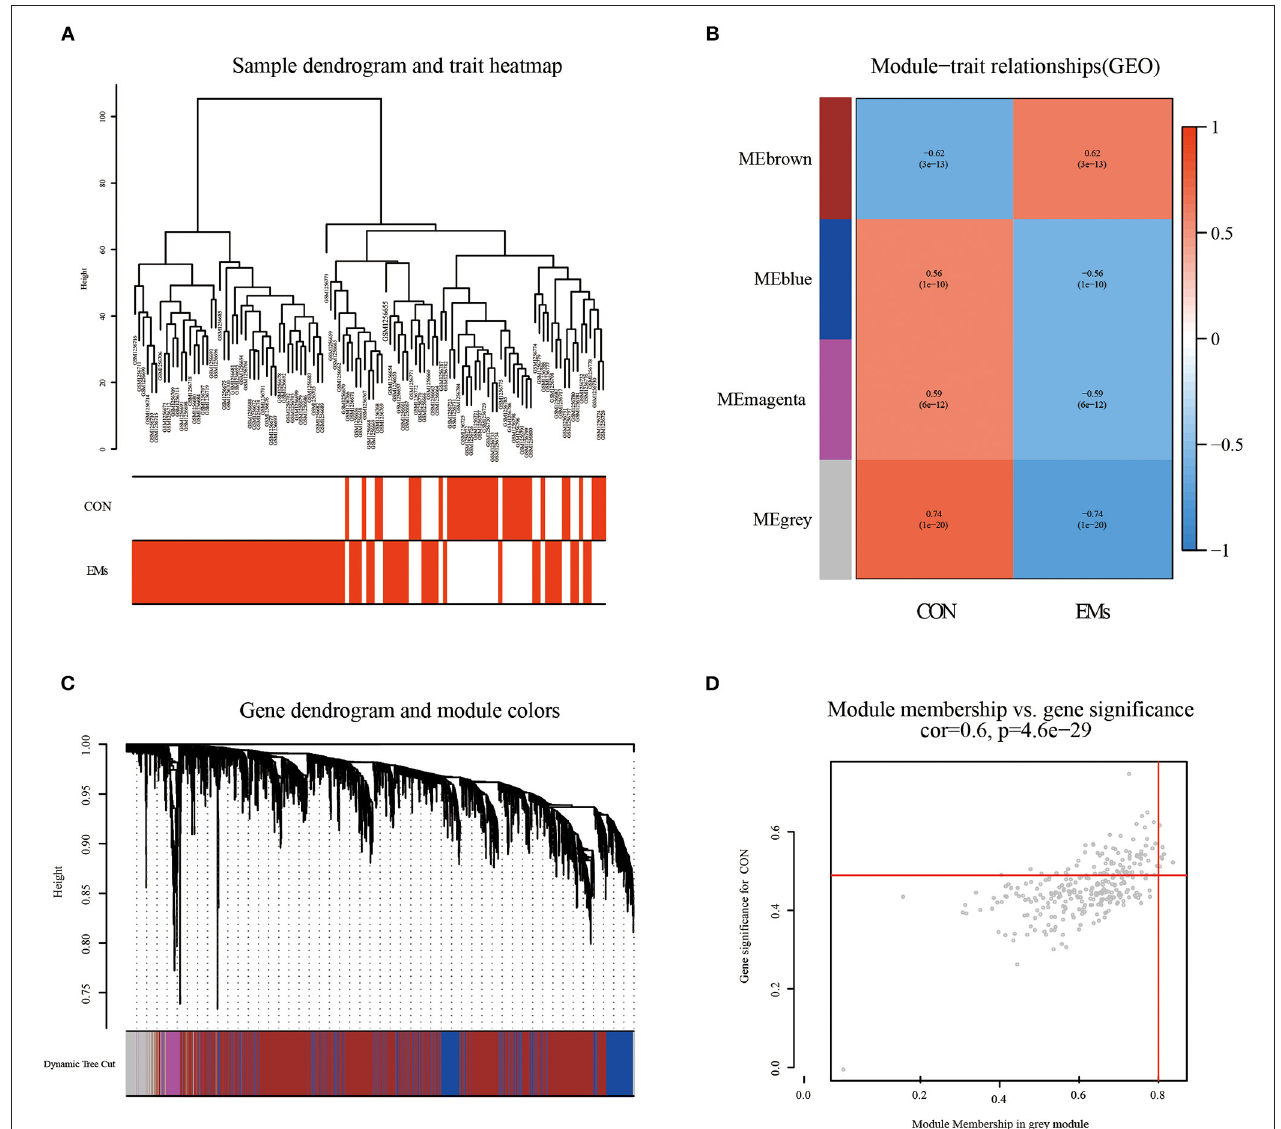
FIGURE 2 | The results of WGCNA on the EMs dataset (GSE51981). (A) Dendrograms and corresponding feature heatmaps of the healthy and EMs samples. (B) Heatmap of correlations between gene modules and clinical features, with each grid showing the correlation between gene modules and clinical features. (C) Cluster dendrogram of co-expressed genes in EMs. (D) Correlation analysis results of gray gene modules and